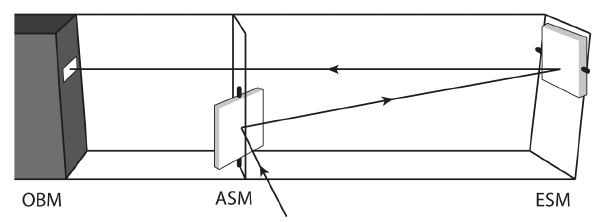
Figure 5. Schematic view of SCIAMACHY multiple mirror setup in limb observation mode. On the left side, the Optical Bench Mod- ule (OBM) and entrance slit. On the right side, the ESM, which if rotated to a 45 ◦ angle will reflect light (curve with arrow head) com- ing from below (nadir) directly into the slit. In the middle, the ASM, which reflects the (limb) light coming from the front and slightly below onto the ESM. Both mirrors have a bead-blasted aluminium surface diffuser on their back side (not shown